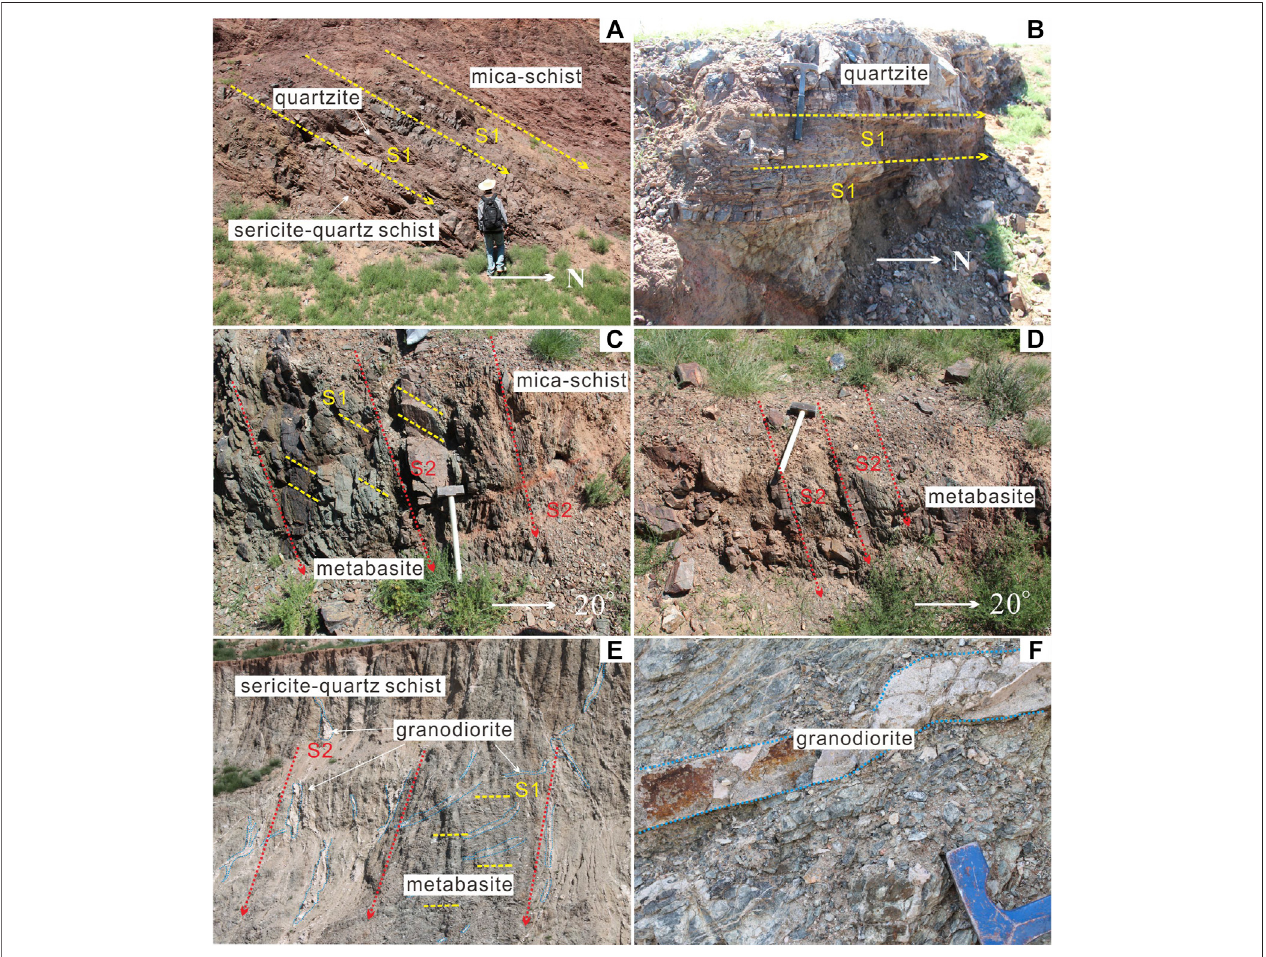
FIGURE 3 | Field photographs showing rocks of different types in the Ondor Sum Group at Airgin Sum, including quartzite (A,B) , sericite-quartz schist (A) , mica- schist (A,C) and metabasite (C,D) , and granodiorite veins (E,F) . Two phases of foliations (S1 and S2) are observed in the outcrops.